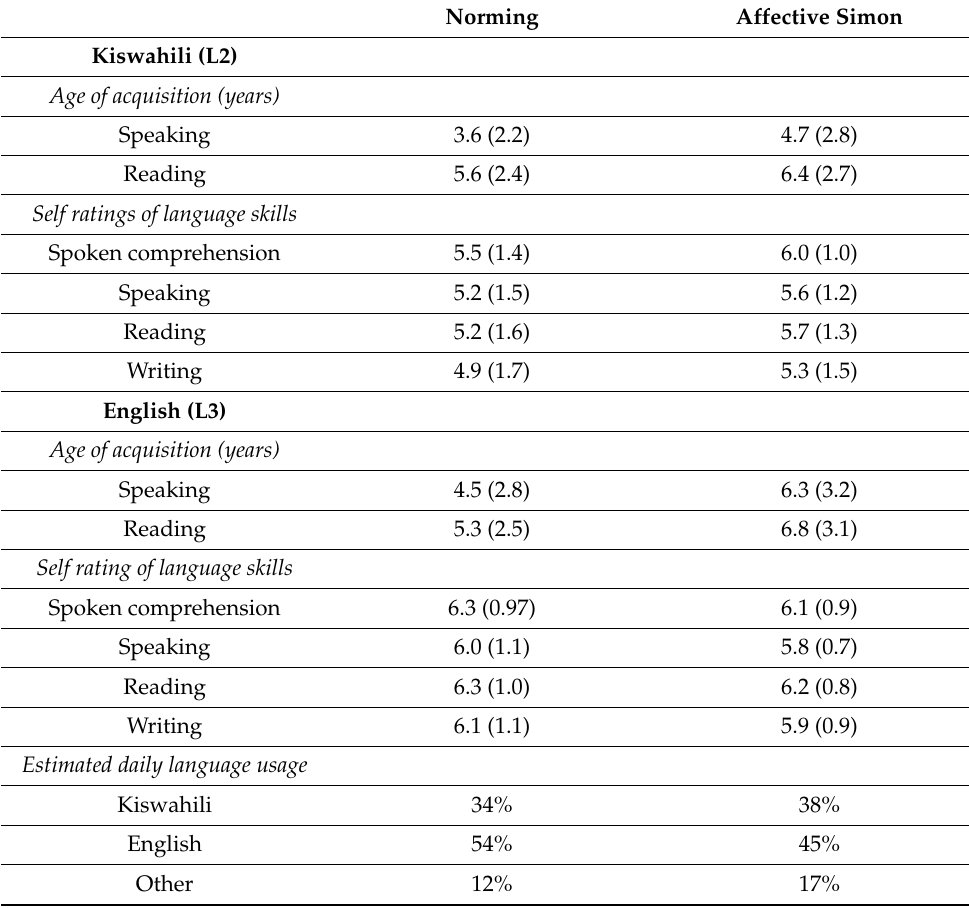
Table 1. Language History Questionnaire Data for Norming and Affective Simon task: Means and standard deviation (in